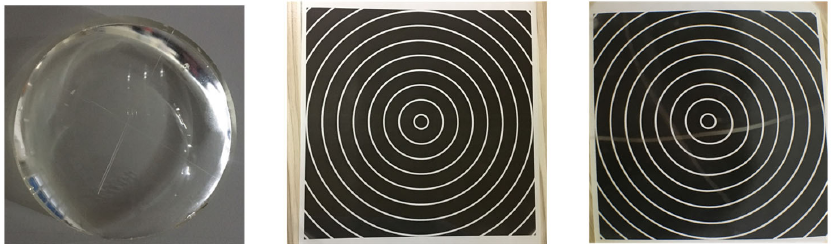
Fig. 2. A testing lens sample and two acquired imaging images using the concentric circles pattern for image acquisition Fig. 3 shows two processed images from transmitted imaging of the concentric circles pattern through a defective lens. The defective image has significant distortions in the lower-left area. The captured images are preprocessed in some steps to increase the clearness of object appearances on transpicuous lenses. To quantify the distortion level of the captured pattern image, Figure 3(a) and Figure 3(b) depict the corresponding binarized image and thinned image for the defective